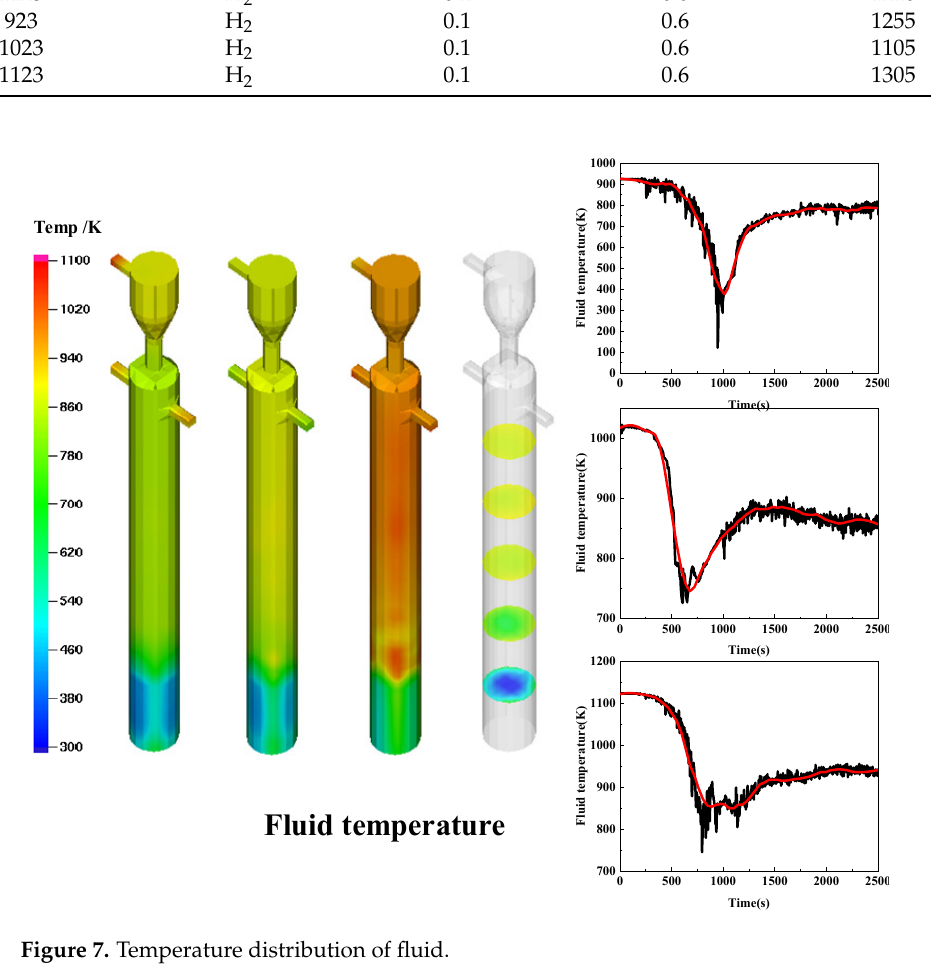
Figure 7. Temperature distribution of fluid.